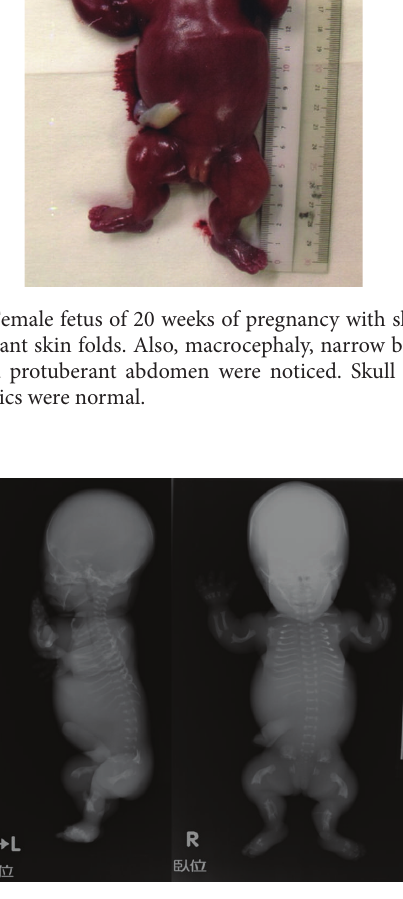
Figure 3: Anteroposterior and lateral radiographs of the fetus showing telephone receiver-like curved femurs and humeri with irregularmetaphyses,H-shapedplatyspondyly,andcurvedclavicles. No cloverleaf skull deformity was